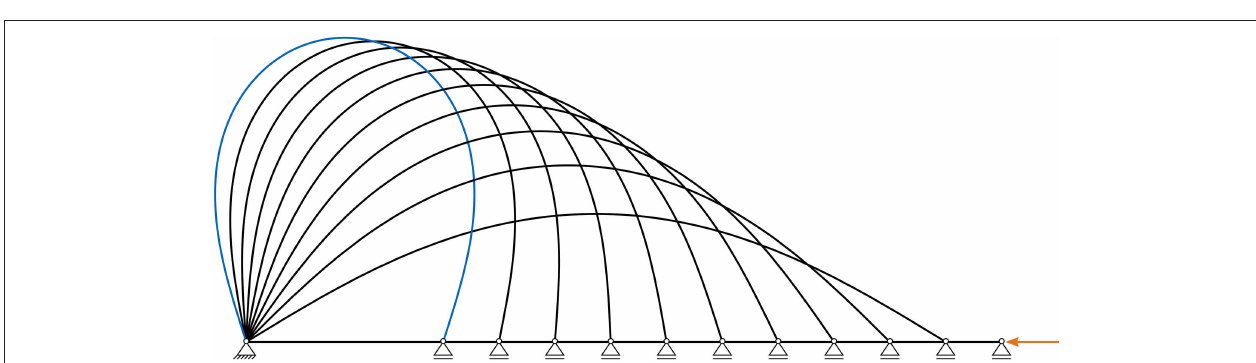
FIGURE 3 | Numerically generated hanging models for a variety of flat shapes.